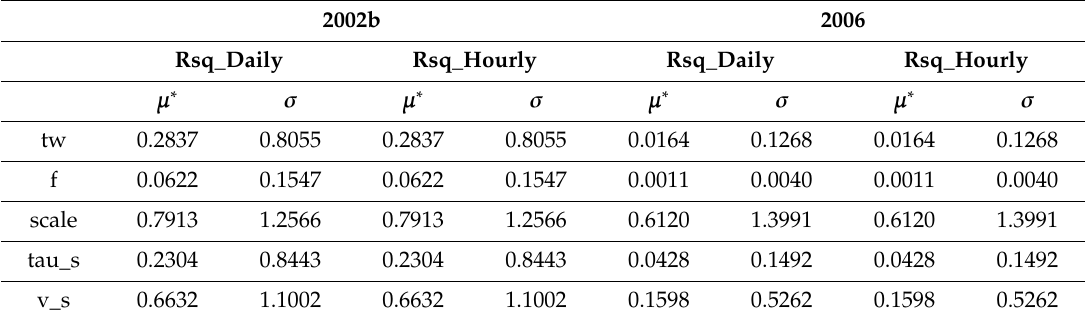
Table 4. Parameter sensitivities of the rsq_daily and rsq_hourly objective functions for the 2002b and 2006 flood